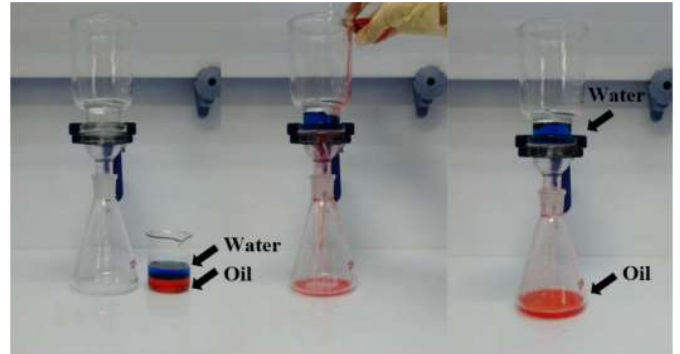
Figure 2. Photos of the oil–water separation experiment. The left, middle, and right are before, during, and after separation, respectively. The oil–water mixture, where the blue liquid is water and the red is oil, was poured onto the superhydrophobic stainless-steel mesh. It was observed that water was trapped on the stainless-steel mesh and oil flowed down through the stainless-steel mesh.